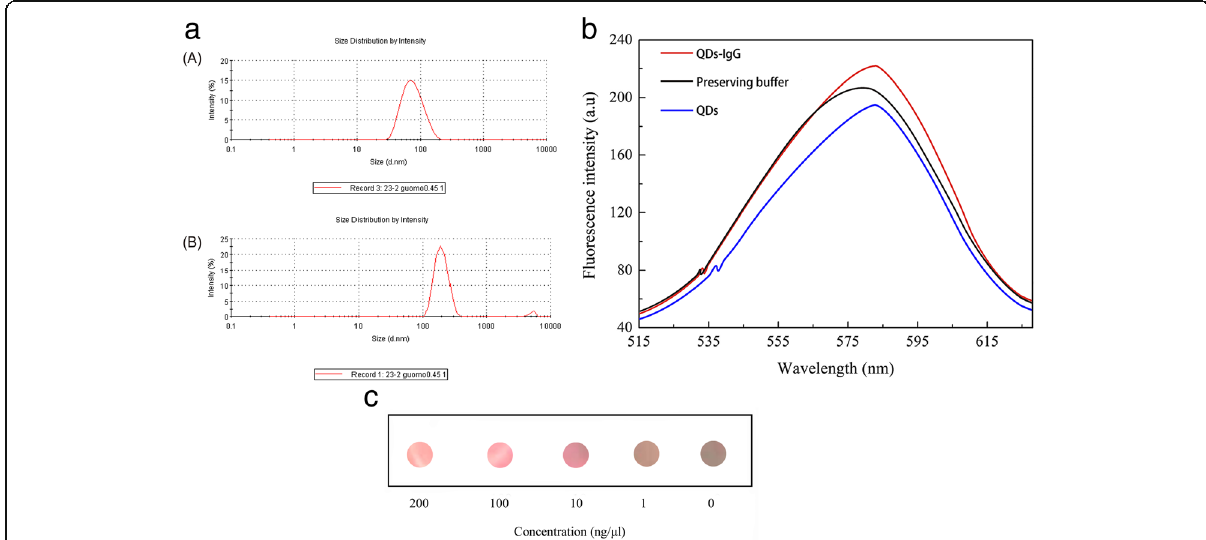
Fig. 3 a Distribution of hydrodynamic diameter of the QDs and QDs-conjugated IgG (goat anti-mouse). ( a ) QDs ’ diameters and ( b ) QDs-conjugated IgG (goat anti-mouse). The average diameter of the QDs is 64.87nm, and that of QDs-IgG is 211.4nm, detected by DLS. b Fluorescence spectra of QDs-IgG (goat anti-mouse), QDs and preserving buffer (2.5mM BS, pH8.0, 0.1% BSA). The QDs-IgG fluorescence emission peak was the same as that of the QDs, indicating that the coupling of IgG to QDs did not alter the QDs ’ optical characteristics. c ELISA method to detect the antibody resistance of QDs-IgG (goat anti-mouse), the PVDF membrane was assessed with